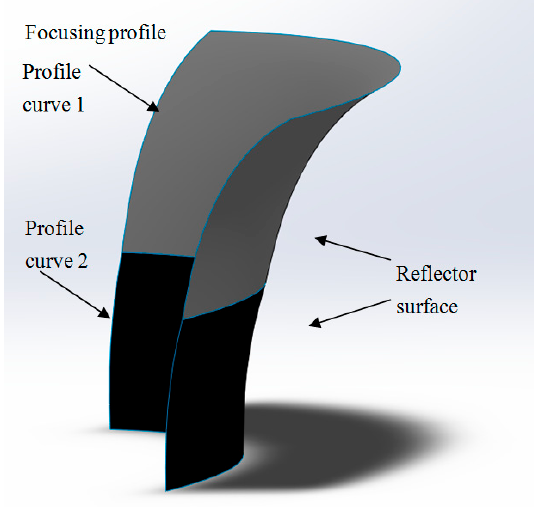
Figure 13. View of the reflector with a double-curved focusing profile.